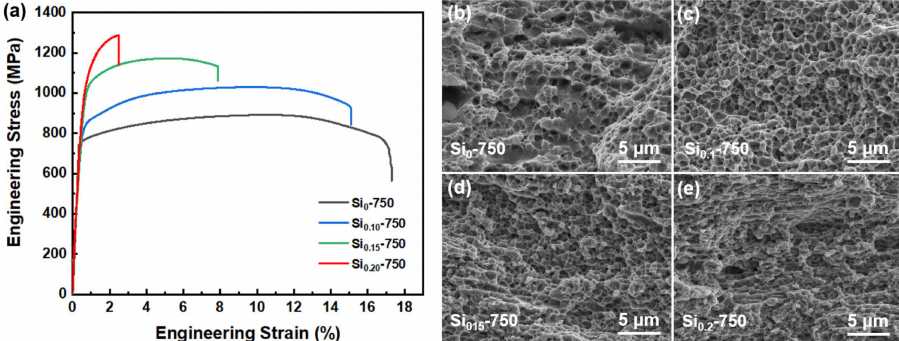
Figure 7. ( a ) Room-temperature tensile engineering stress-strain curves of the Si x -750 MEAs. The fracture surfaces of the ( b ) Si 0 -750, ( c ) Si 0.1 -750, ( d ) Si 0.15 -750, and ( e ) Si 0.2 -750